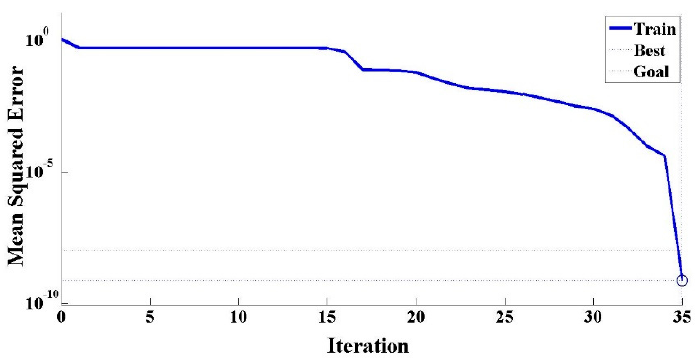
Figure 8. Reduction of deviation by training.